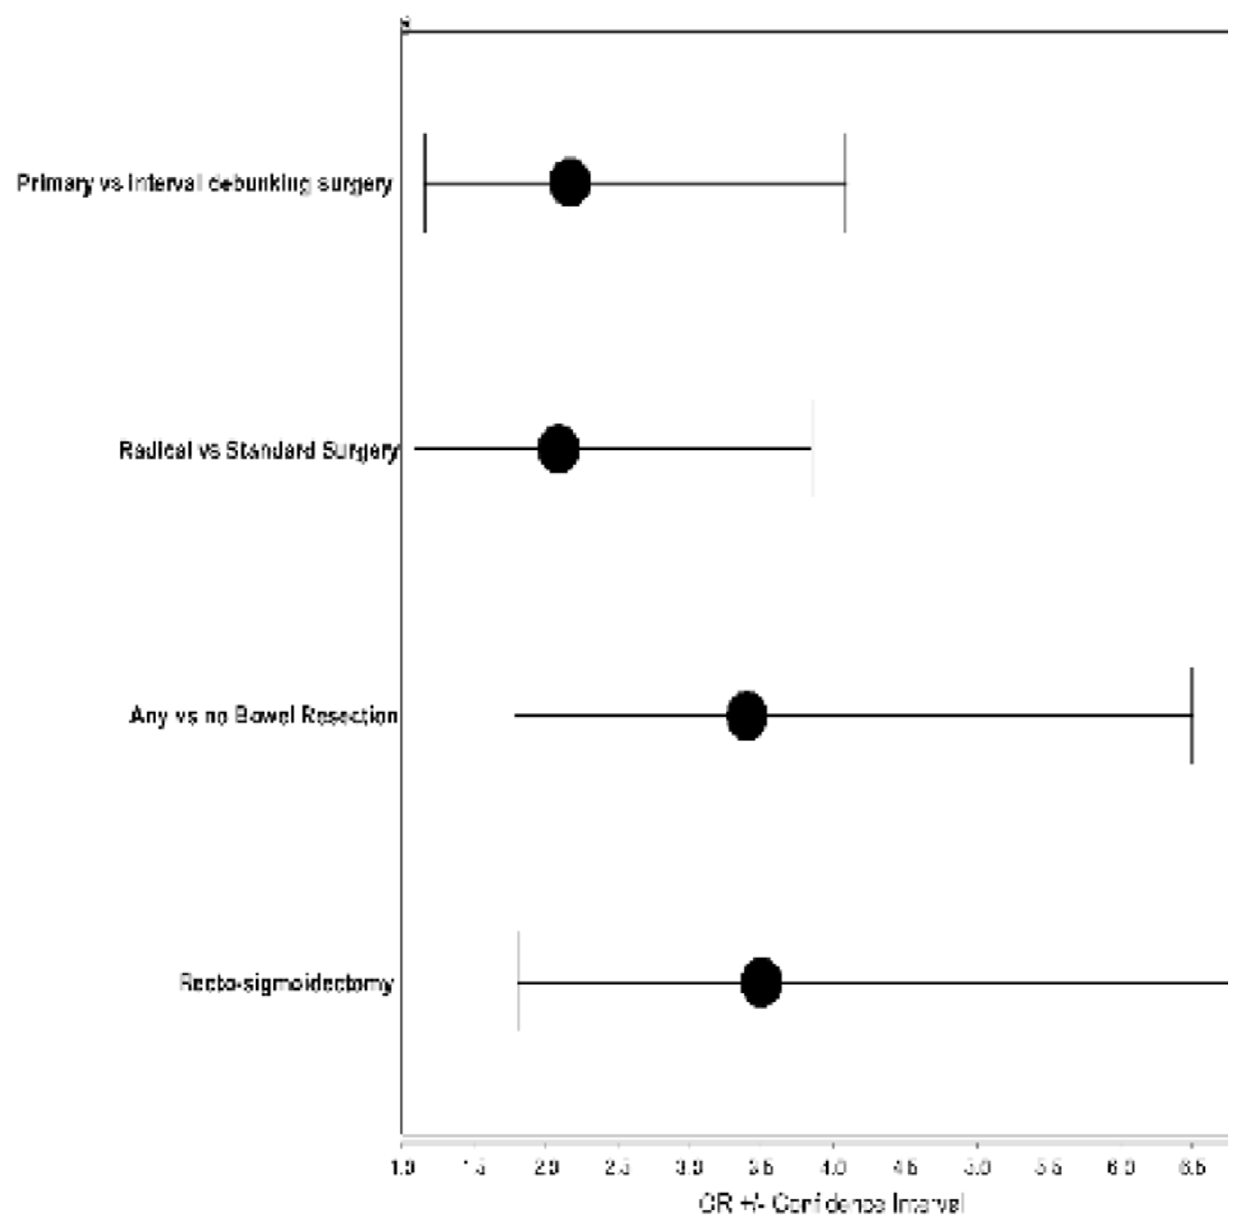
Figure 2. Odd ratios for different parameters associated to occurrence of complications.